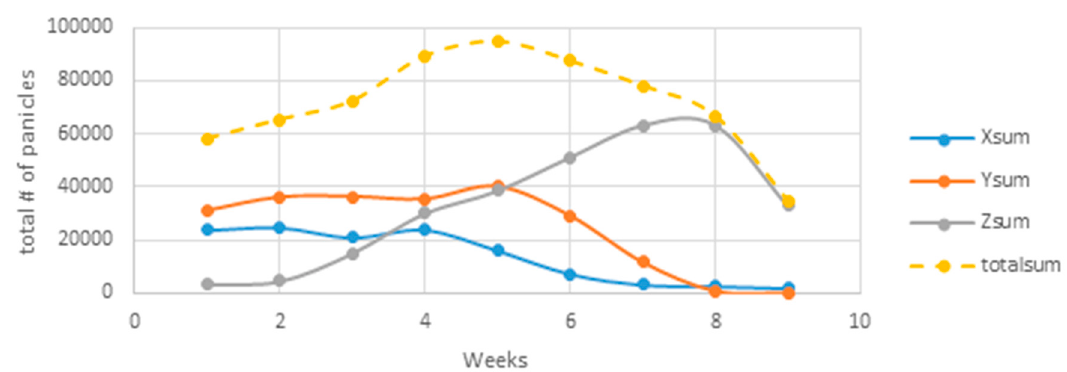
Figure 11. Flower stages trend analysis across weeks for an orchard .